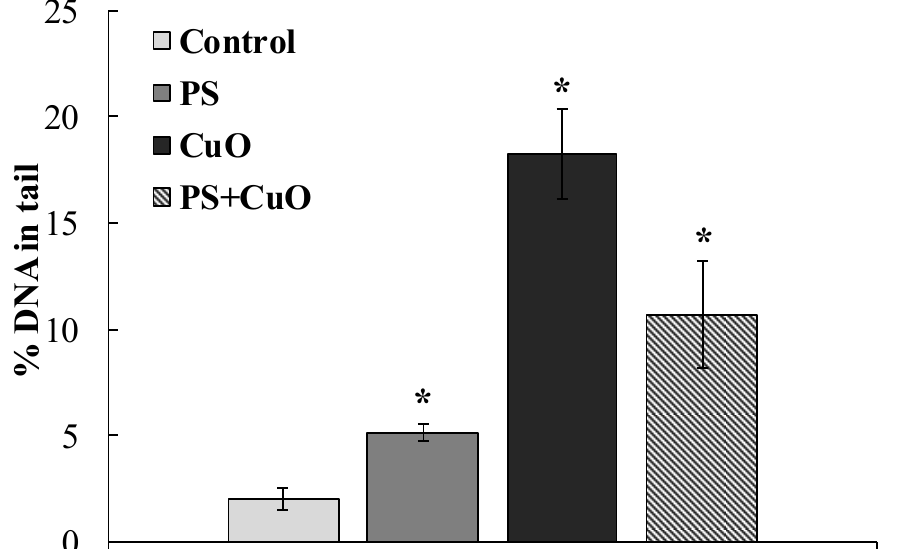
Figure 3. Assessment of digestive gland cell DNA damage from control and experimental groups (mean ± standard deviation; control: n = 30, experimental: n = 1500). *—difference from the control was significant ( p < 0.05).